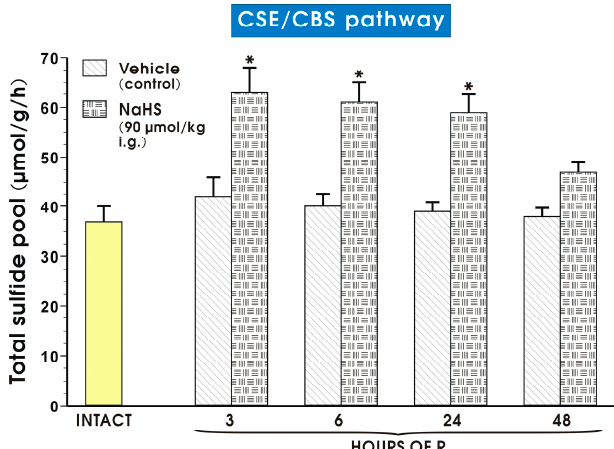
Figure 9. Total sulfide pool released by CSE/CBS activity pathway in gastric mucosa of intact rats and those pretreated with vehicle (saline) or NaHS (90 μ mol/kg i.g.) and exposed to I followed by 3, 6, 24 or 48 h of R. Results are mean ± S.E.M of 4–5 rats per each experimental group. An asterisk indicates a significant change as compared with the value obtained in intact rats ( p < 0.05).